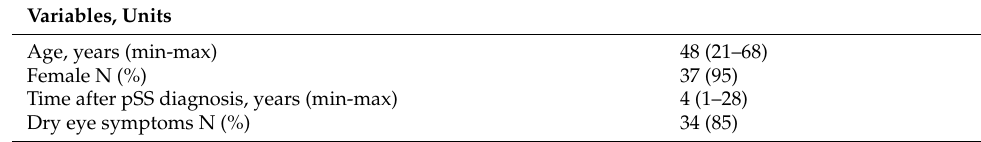
Table 1. Baseline characteristics of the study pSS patients. Variables,